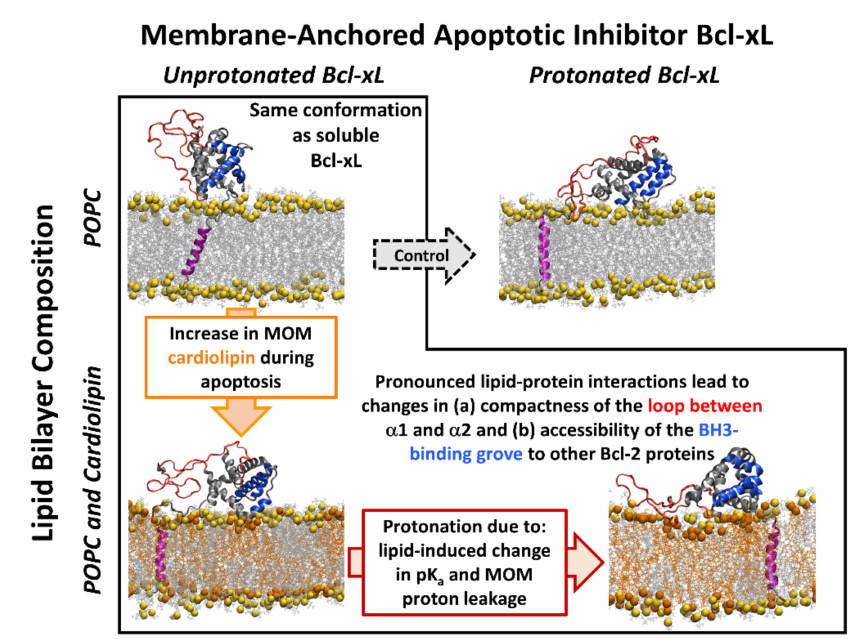
Figure 7. Schematic summary of the effects of cardiolipin and protonation on the conformational dynamics of membrane-anchored Bcl-xL studied by MD simulations. Four systems examined in this study are illustrated by the following representative snapshots from microsecond MD trajectories: 2.44 µ s for E − , D − , and H + Bcl-xL in a POPC lipid bilayer (top left); 3.66 µ s for E ◦ , D ◦ , and H ◦ Bcl-xL in a POPC lipid bilayer (top right); 4.30 µ s for E − , D − , and H + Bcl-xL in a 2:1 POPC:TOCL lipid bilayer (bottom left); and 3.71 µ s for E ◦ , D ◦ , and H ◦ Bcl-xL in a 2:1 POPC:TOCL lipid bilayer (bottom right). In the absence of cardiolipin or protonation (top left), the soluble head domain of the membrane-anchored Bcl-xL does not interact with the lipid membrane surface and largely retains the conformation of the soluble protein [12–14]. The addition of cardiolipin (bottom left, orange), which corresponds to physiologically observed changes of MOM during apoptosis [20,21], induces membrane interactions of the soluble head domain of the protein, resulting in protein conformational changes (see Figures 3–7). These interactions become more prominent upon subsequent protonation of all acidic and His residues (bottom right), resulting in (i) lipid interactions of the loop between helices α 1 and α 2 (highlighted in red) and (ii) reorientation of the binding grove (highlighted in blue) that can engage BH3 domains of the other Bcl-2 proteins. Physiologically, the protonation corresponds to the bilayer-induced shifts in pK a [15,16] or proton leakage at the early stages of MOMP [15,16]. Note that no loop-lipid binding or reorientation of the BH3-binding groove was observed in the control MD simulations of protonated Bcl-xL in the absence of cardiolipin (top right). Conformational changes and lipid interactions induced by cardiolipin and in the membrane-anchored Bcl-xL provide structural insights into the initial protein conformational changes on the pathway towards fully refolded membrane-inserted Bcl-xL